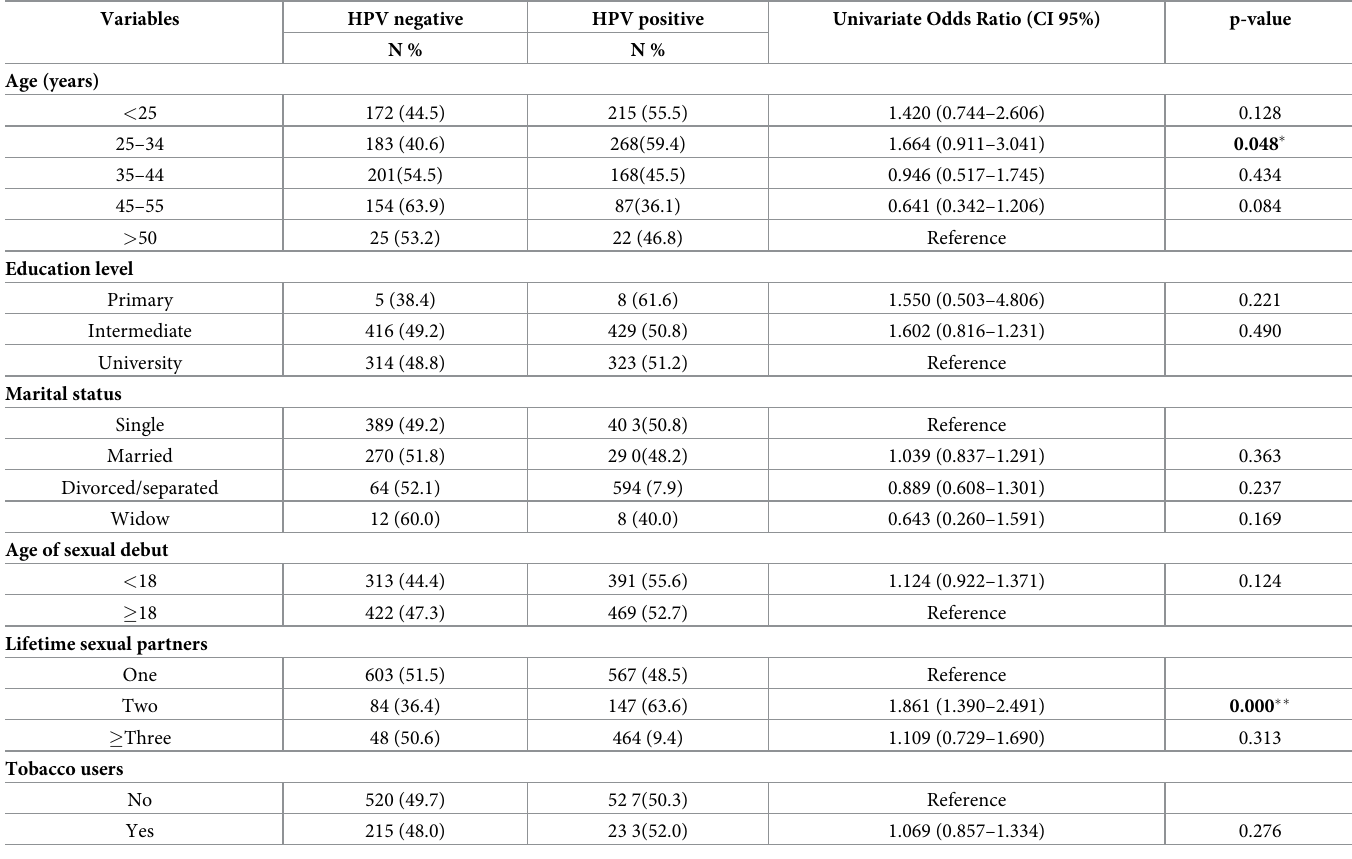
Table 1. The profiles of the sociodemographic characteristics of the study